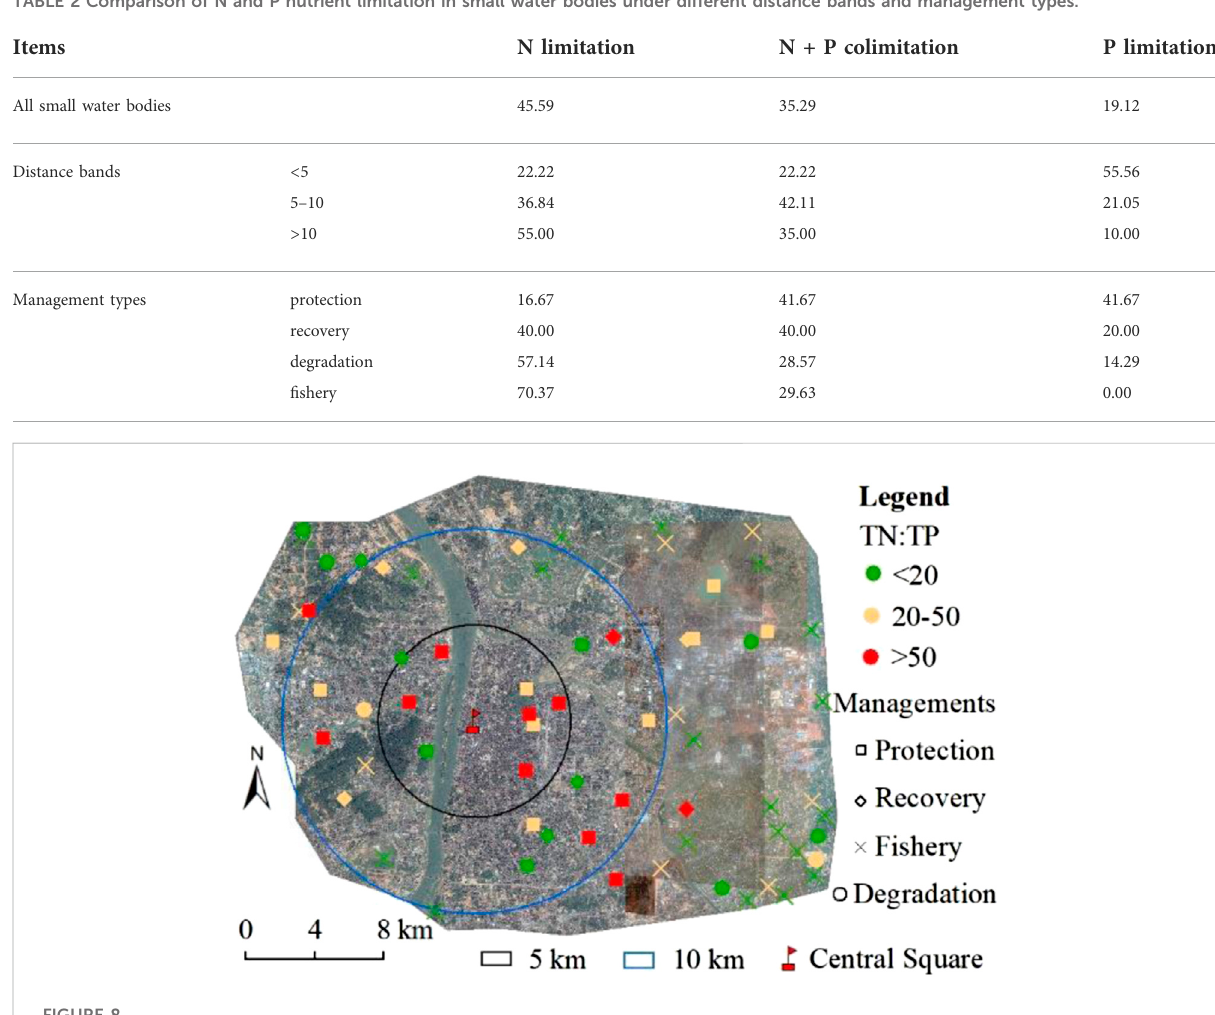
FIGURE 8 Distribution of TN:TP ratios (mol/mol) in each sampled small water body.